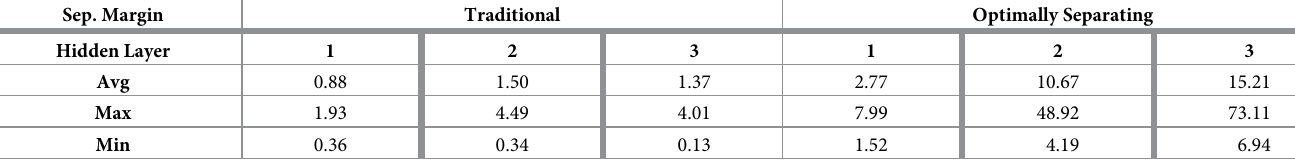
Table 6. Comparison of separating margins between traditional and optimally-separating ANNs. Sep. Margin